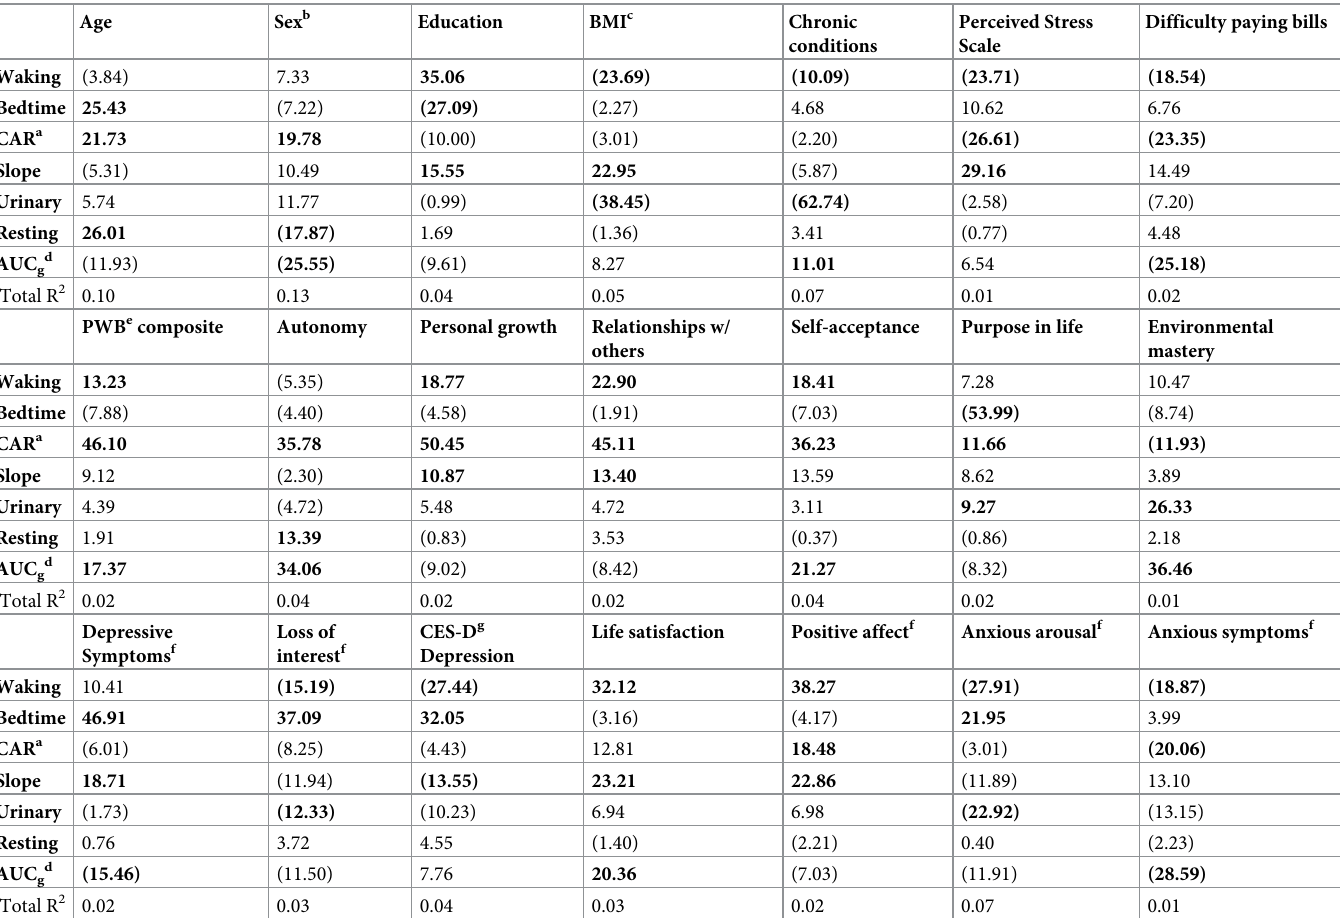
Table 4. Percentage of variance explained by cortisol measures from relative weight analysis (N =